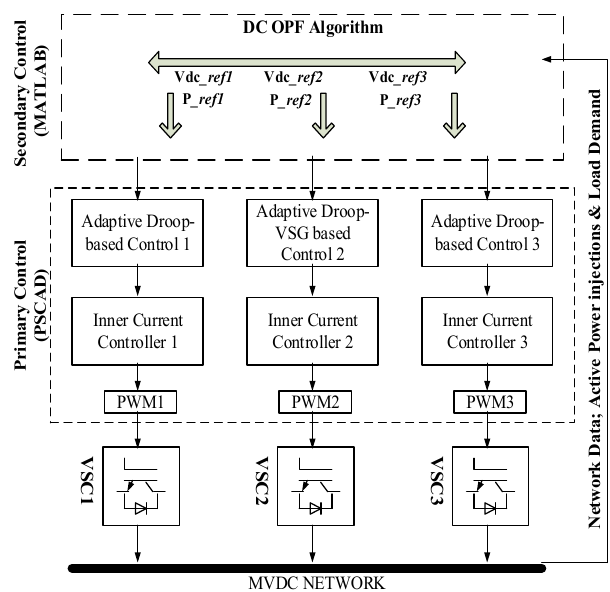
Figure 4. Hierarchical control system framework.